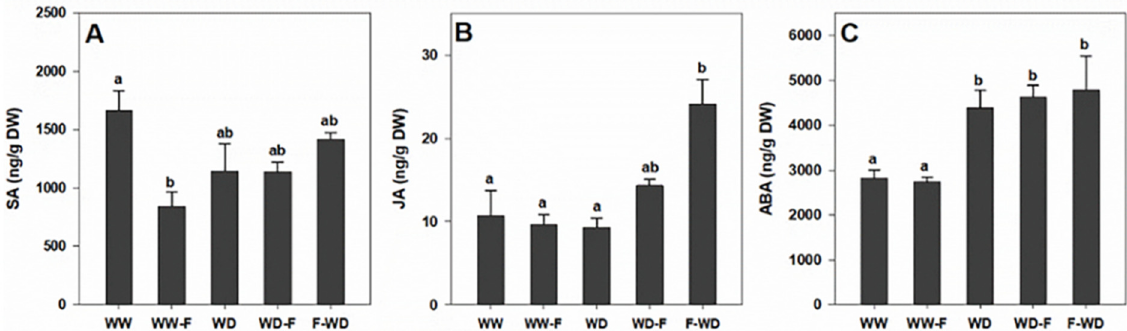
Figure 6. ( A ) Salicylic acid (SA), ( B ) jasmonic acid (JA), and ( C ) abscisic acid (ABA) of grapevines exposed to WW (well-watered control); WW-F (well-watered fungal inoculation); WD (water deficit); F-WD (inoculation before water deficit); WD-F (inoculation after water deficit). Different lowercase letters indicate significant differences among the five treated groups ( p ≤ 0.05).